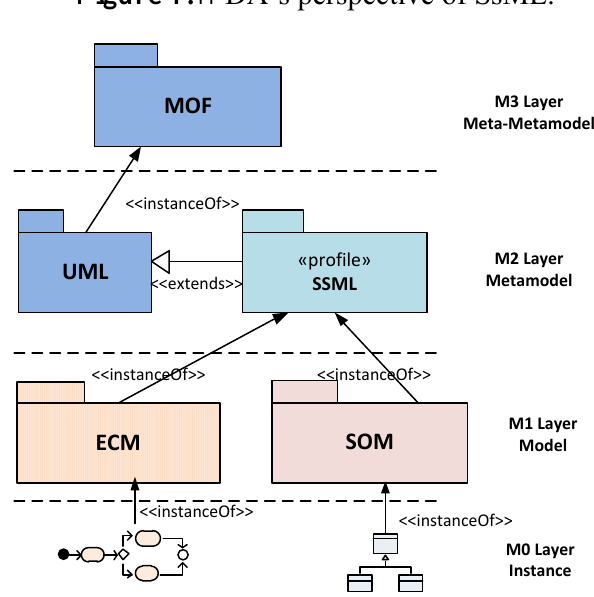
Figure 1. MDA’s perspective of